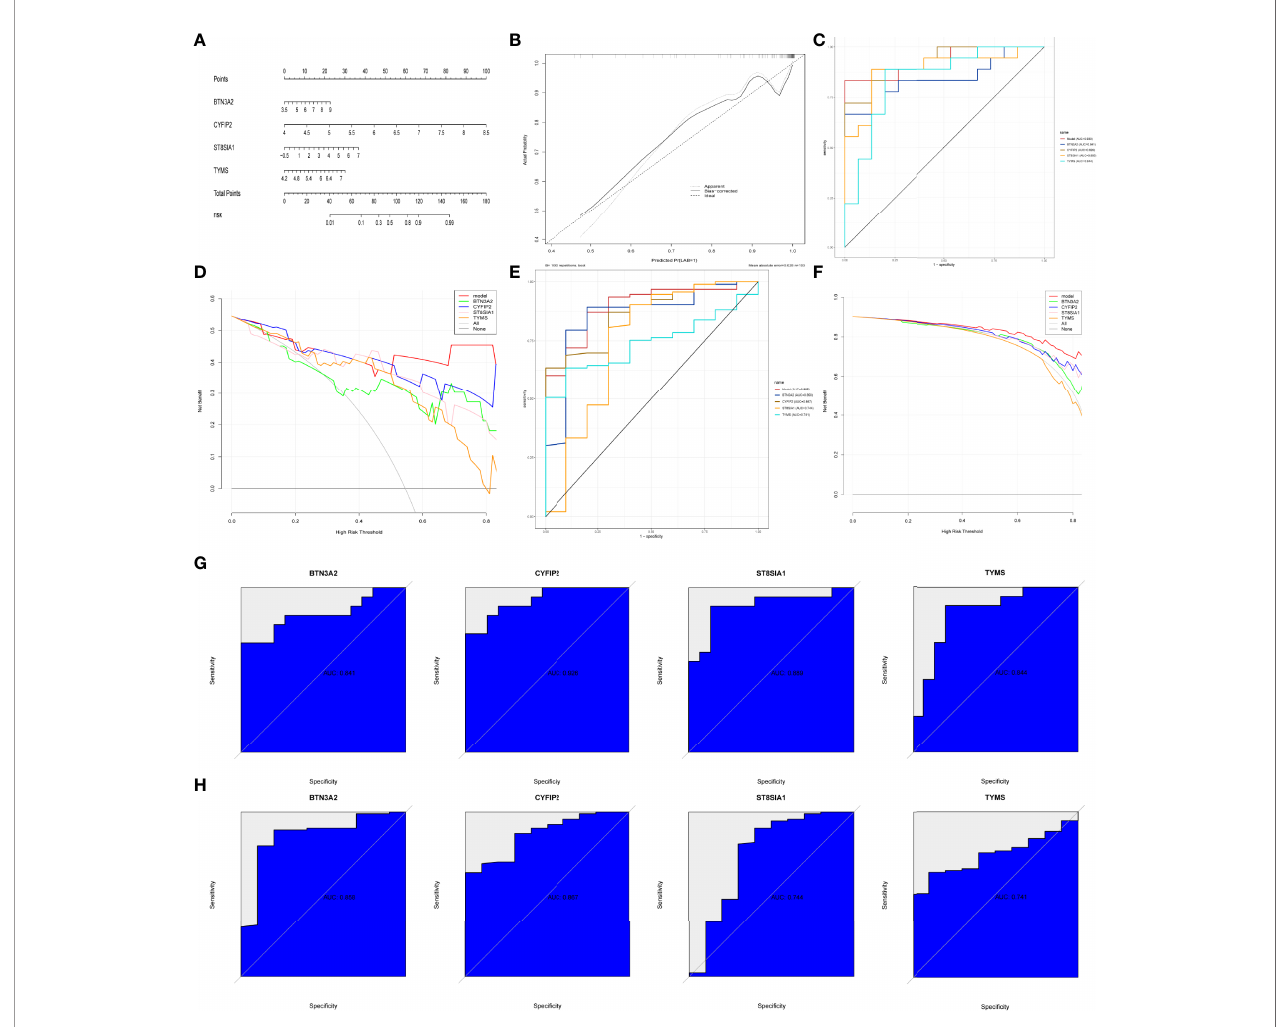
FIGURE 7 | Construction and validation of the RA diagnostic column line graph model. (A) Column line graphs are used to predict the occurrence of RA. (B) ROC curves to assess the clinical value of the column line graph model. (C) Calibration curves to assess the predictive power of the column line graph model. (D) DCA curves to assess the clinical value of the column line graph model. (E, F) Validation set to verify ROC and DCA curves. (G) ROC curves of the feature genes in the training set. (H) ROC curves of the feature genes in the validation